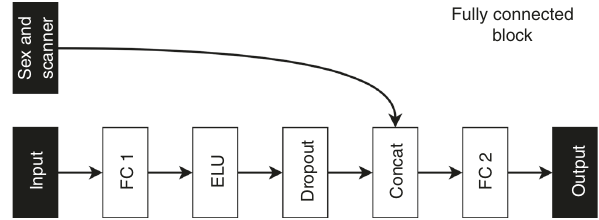
Fig. 5 A fl owchart showing the components of the proposed fully connected block. Fully connected layer one (FC1), concatenation layer (Concat), fully connected layer two (FC2).